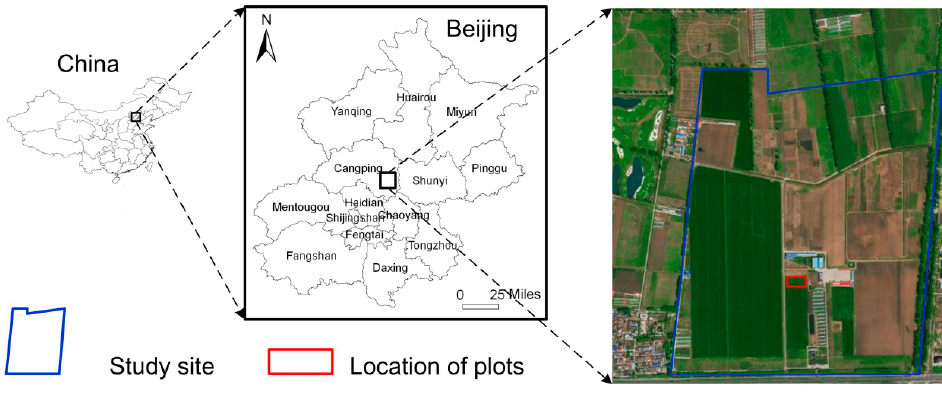
Figure 1. Study site and experiment plot. Table 1. Summary of cultivar, soil characteristics and treatments for the four